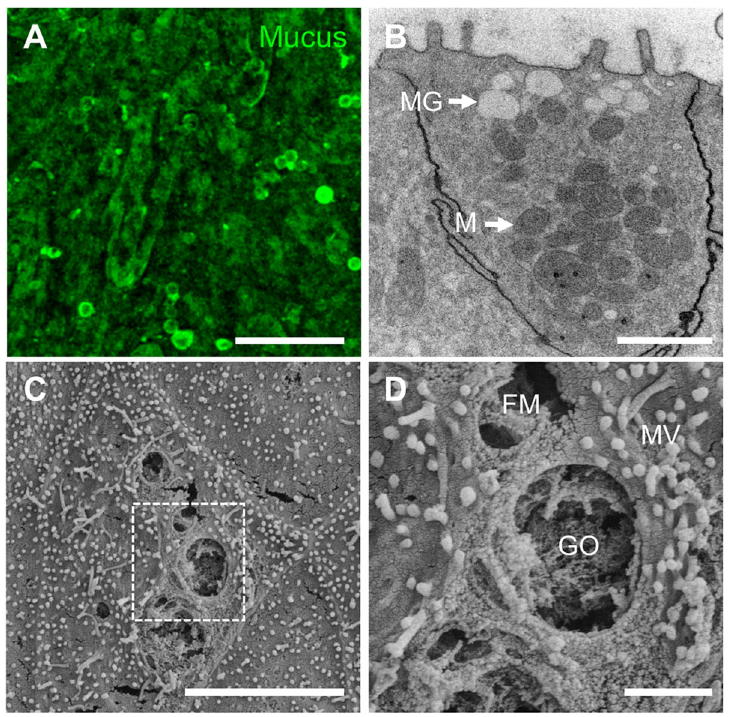
Fig 4. Visualization of mucus production and goblet cells in the canine colonoid-derived monolayer. The mucus production ( A ; WGA) was visualized by live-cell imaging at the apical surface of the monolayer. Bar, 20 μ m. ( B ) A representative TEM image shows the goblet cell with multiple mucin granules (MG) and mitochondria (M). Bar, 1 μ m. ( C ) A low magnification SEM image of a goblet cell on the apical cell surface of the canine colonoid-derived monolayer. Bar, 5 μ m. ( D ) A high magnification of a goblet cell orifice (GO), a fenestrated membrane (FM) extending deep into the cell, and microvilli (MV) from C indicated by a white dashed box. Bar, 1 μ m.